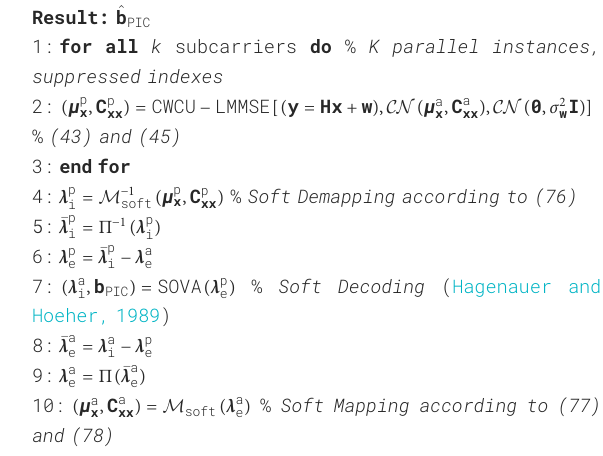
Algorithm 4. Iterative MMSE-PIC Detector.